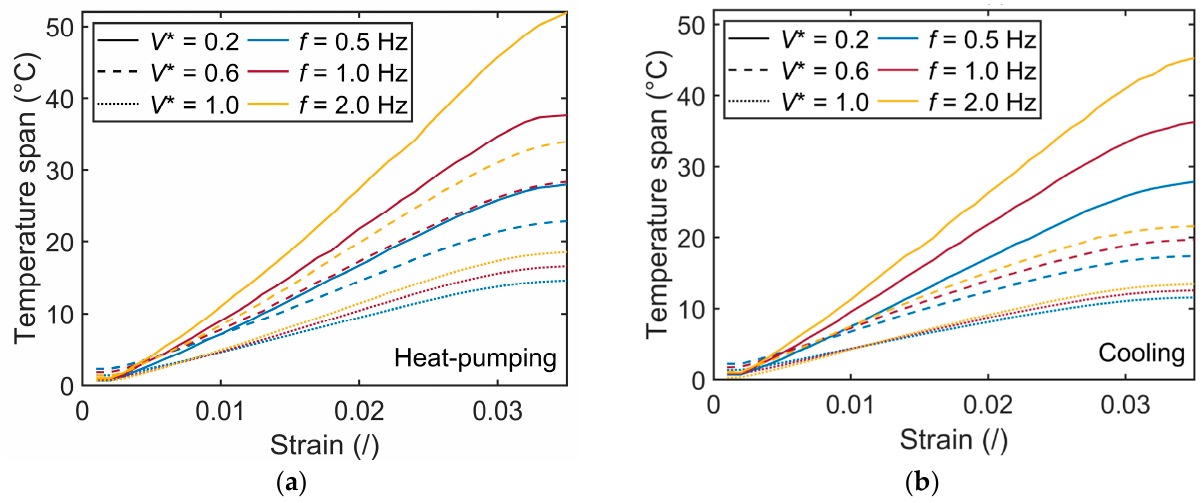
Figure 10. The effect of different applied strains at different operating conditions (operating frequency and displaced fluid volume ratio) on established temperature spans at no thermal load conditions for heat-pumping ( a ) and cooling ( b ).